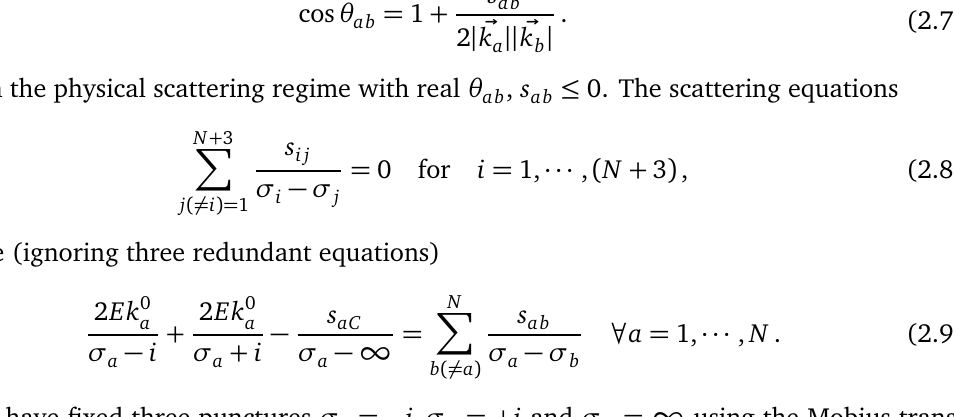
(cid:126) (cid:126) k k and , with the same energy k 0 A B = s ∀ a , b = 1, ··· , N between them. Particle ab